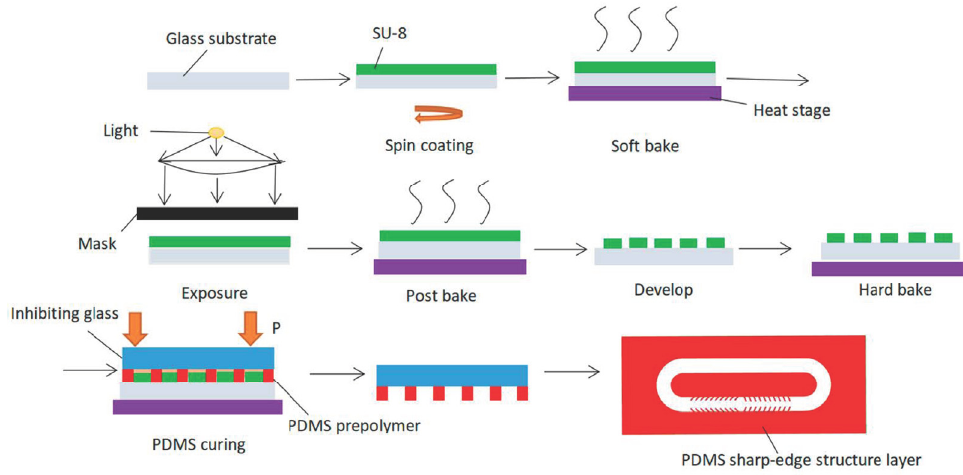
Figure 4. The fabrication scheme of PDMS sharp-edge structure layer (the last image is a top view, and the other images are side views).